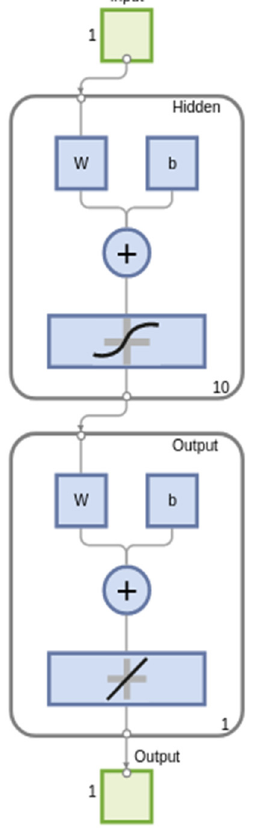
Figure 4. The ANN architecture.